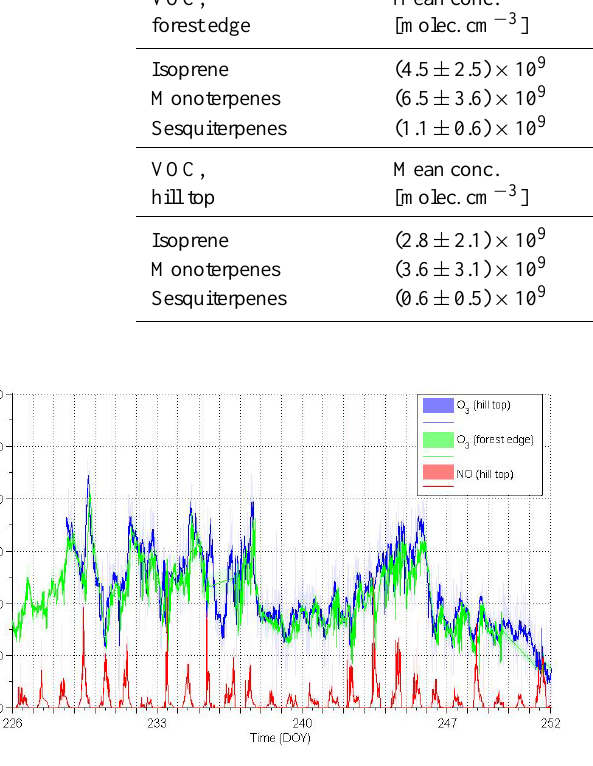
Figure 8. Top: calculated OH concentrations at the hill top. Bottom: detected NO 3 radical mixing ratios at the same